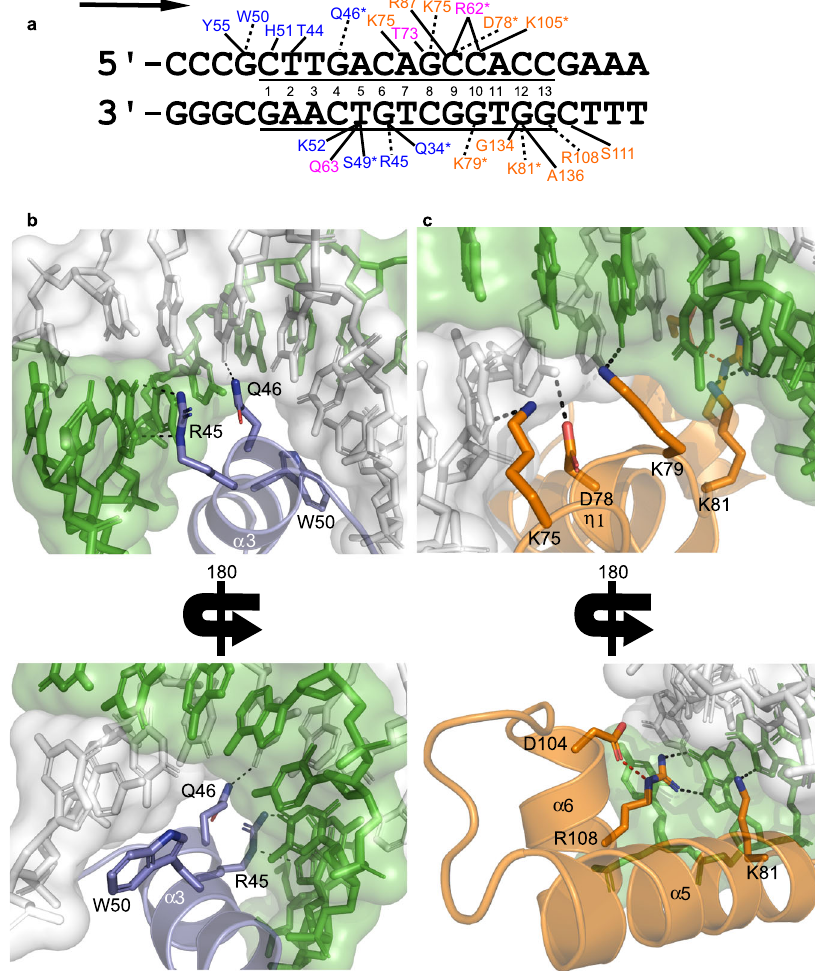
Fig. 3 Repressor:DNA interactions. a Double-stranded DNA sequence present in the crystal structure is shown, with the consensus sequence underlined. The numbers are present to identify each nucleotide of the consensus. Residues that contact the DNA are listed, with dashed lines indicating interactions with the DNA bases, while solid lines designate residues that contact the DNA backbone. All polar contacts shown are 3.2 Å or less, and an asterisk indicates contacts that are only observed in the higher resolution selenomethionine structure. Residues are color-coded as in Fig. 1a, and the arrow indictates the direction of transcription. b Interactions between R45, Q46, and W50 of the α 3 helix in the HTH domain and DNA bases are shown. c Interactions between the Stoperator domain and DNA bases. At the beginning of this domain, the η 1 3 10 helix properly positions K75, D78, and K79 to contact bases of the DNA. K81 sits at the base of the α 5 helix. R108 in the α 6 helix is properly positioned to bind DNA via an interaction (colored red) with D104. In both panels b , c , the protein and DNA are colored coded as in